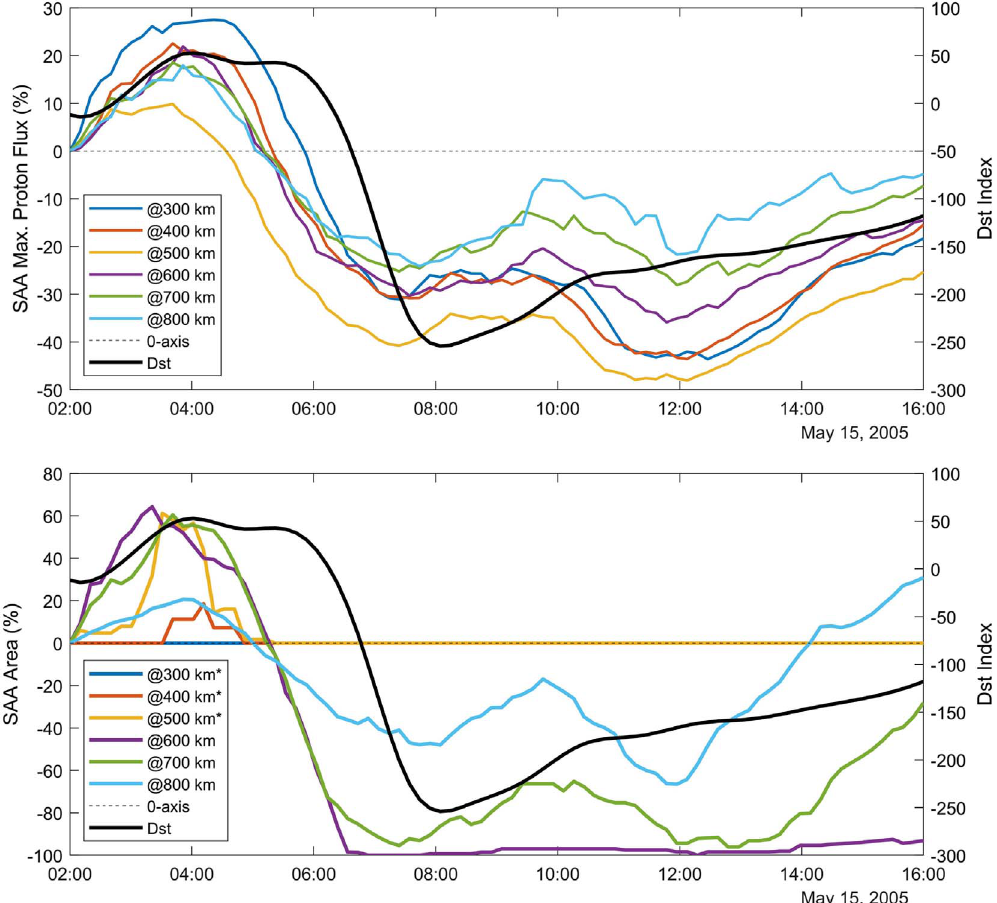
Fig. 7. The fi gure displays the time pro fi les of the variations of both SAA parameters: the maximum proton fl ux and the corresponding area with respect to the beginning of the geomagnetic storm at several altitudes. Please note that the vertical axis of the bottom panel for the lower altitudes, 300, 400, and 500 km corresponds to the SAA actual area, not to the variations; this was because their related proton fl ux areas were much lower than the area threshold at the beginning of the geomagnetic storm.